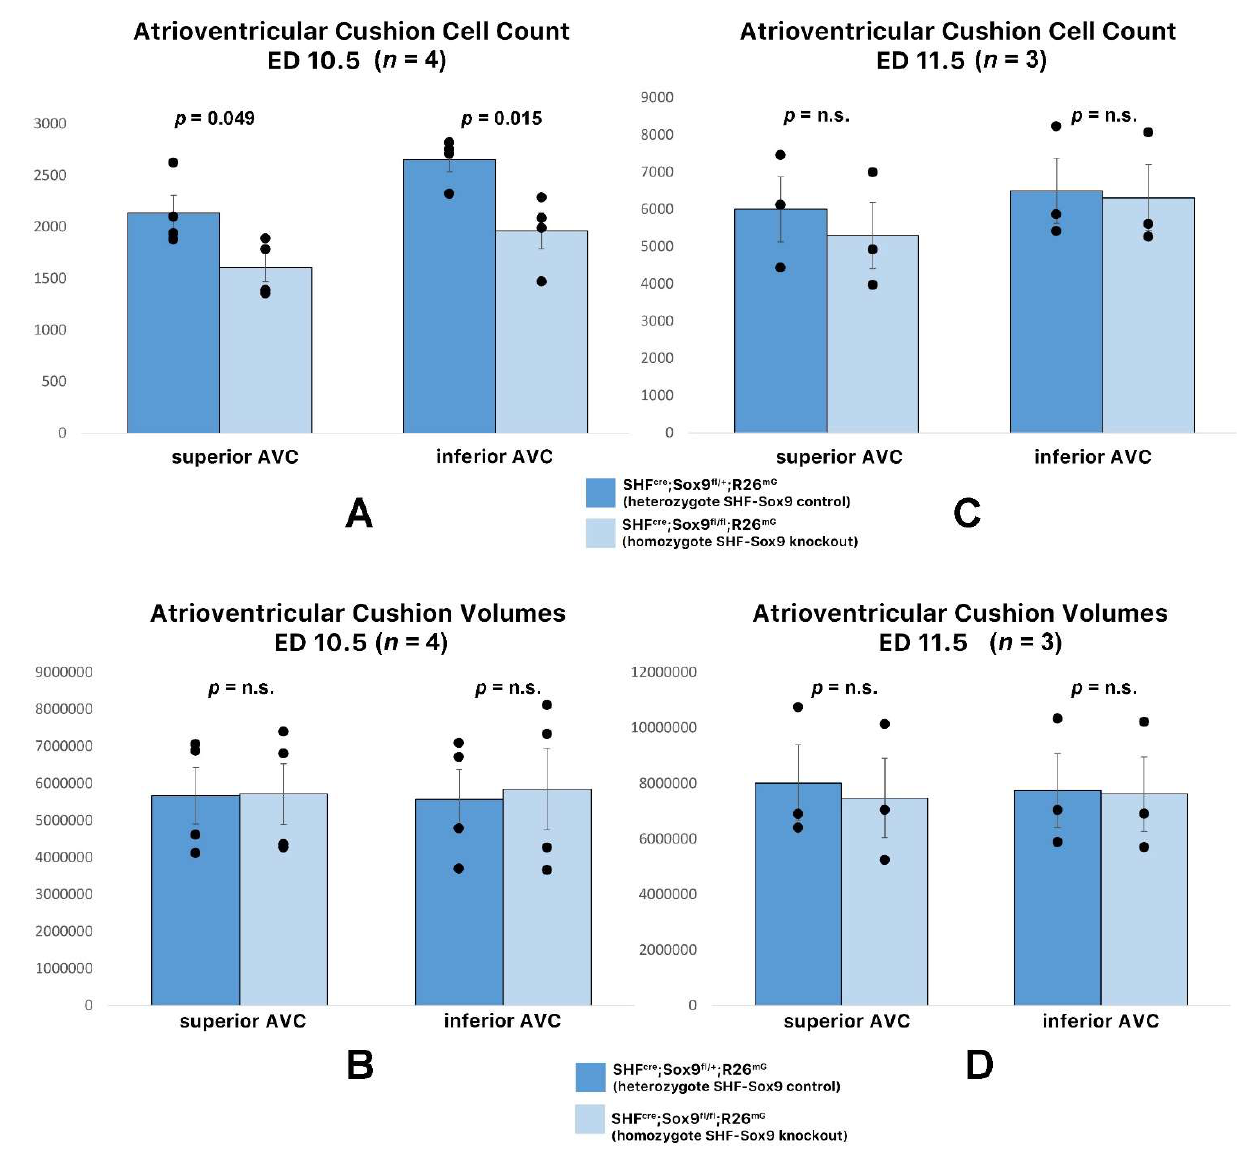
Figure 9. Deletion of Sox9 from the SHF does not significantly affect the development of the AV cushions. Quantitative analysis of the number of cells in, and the volume of, the developing AV cushions of SHFcre;Sox9fl/fl;[R26mG] Sox9 knockouts and heterozygote SHFcre;Sox9fl/+;[R26mG] controls at ED10.5 and ED11.5. The analysis shows a slight reduction in the number of mesenchymal cells in the cushions of the knockouts at ED10.5 ( A ) but no change in the overall volume of the cushions ( B ). The SHF-specific removal of Sox9 has no significant effect on the number of mesenchymal cells in the cushions at ED11.5 ( C ) or on the volume of the cushions at this stage ( D ).